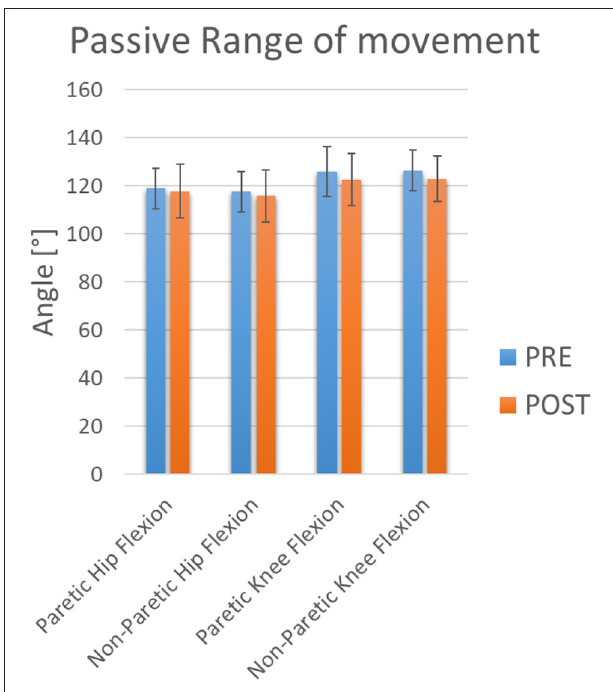
FIGURE 4 | PROM Flexion. The blue and orange bars show the mean value (M). The standard deviation (SD) is also shown through error bars.